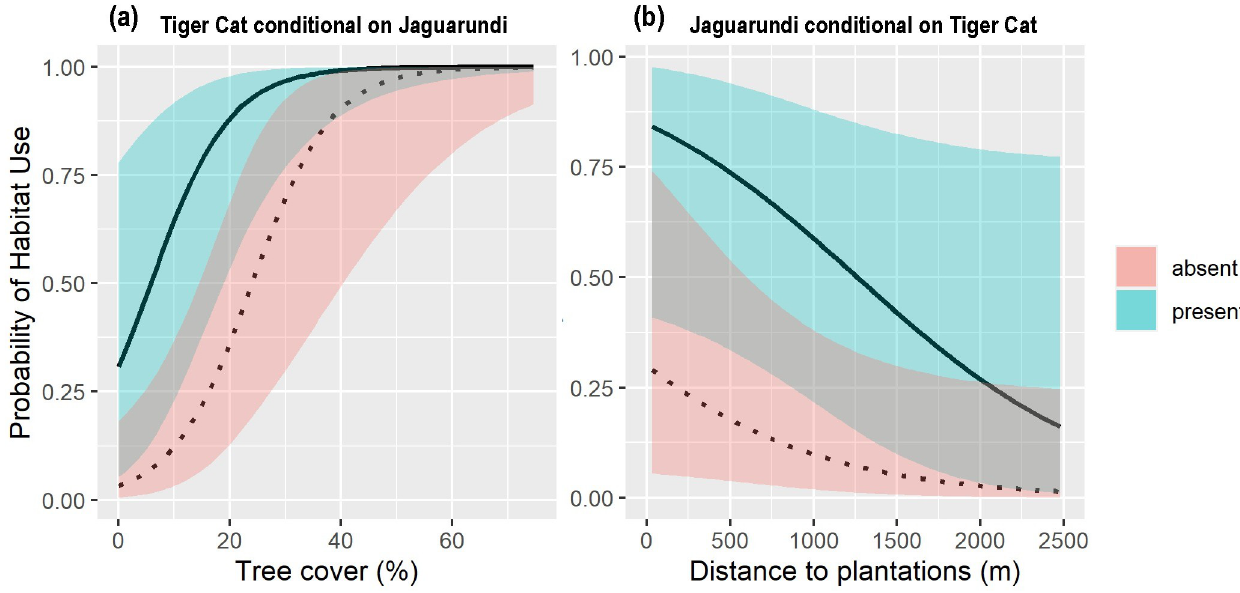
Fig 3. Conditional occupancy probability of (a) Northern tiger cat conditional on jaguarundi and (b) Jaguarundi conditional on northern tiger cat.